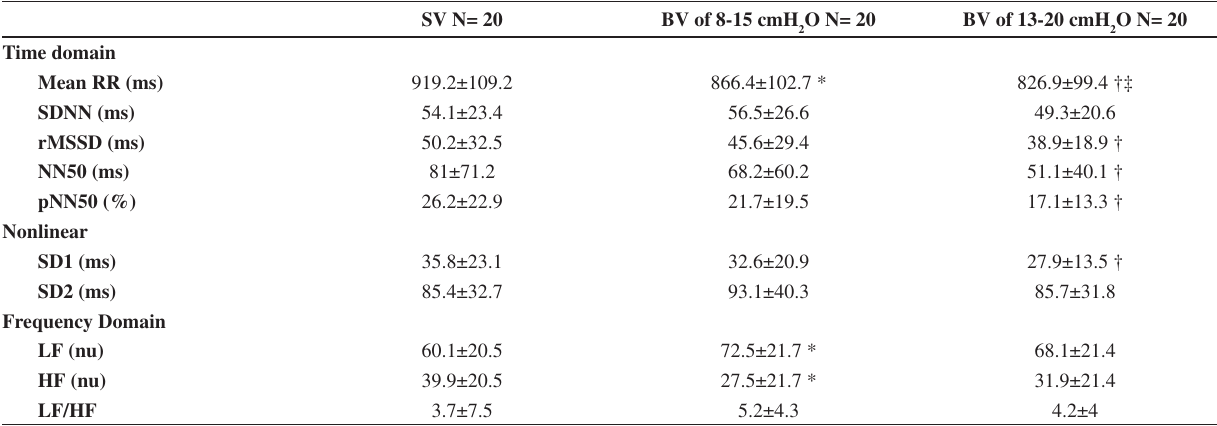
Mean RR= the mean of R-R intervals, in ms; SDNN= standard deviation of all R-R intervals, in ms; rMSSD= root mean square of the squares of the differences between successive R-Ri, in ms; NN50= number of successive R-Ri interval pairs that differ by more than 50 ms; pNN50= percentage of suc- cessive R-Ri pairs that differ by more than 50 ms; SD1= the standard deviation of the Poincaré plot perpendicular to the line-of-identity, in ms; SD2= the standard deviation of the Poincaré plot along the line-of-identity, in ms; LF= low frequency, in normalized units; HF= high frequency, in normalized units; LF/HF= ratio of low frequency to high frequency. * Bilevel of 8-15 cmH O versus SV; † Bilevel of 13-20 cmH O versus SV; ‡ Bilevel of 13-20 cmH O 2 2 2 versus Bilevel of 8-15 cmH O. Repeated-measures analysis of variance ( ANOVA) with the Tukey post-test. Data expressed in mean and standard deviation. 2